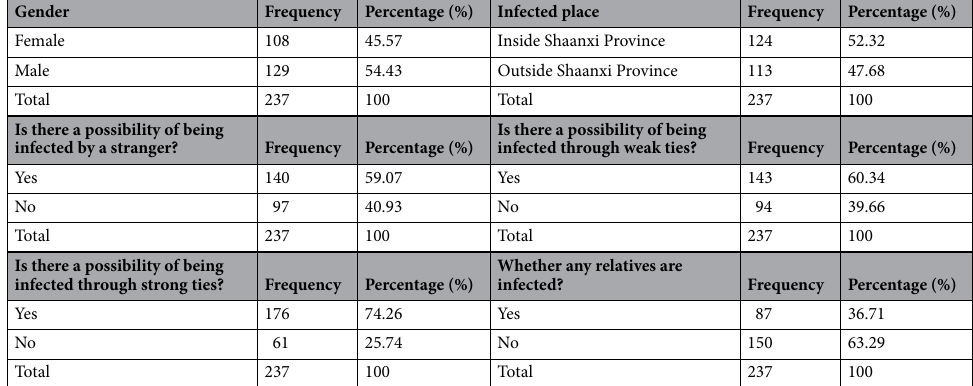
Table 1. Descriptive statistics of cases with COVID-19 in Shaanxi Province, China.